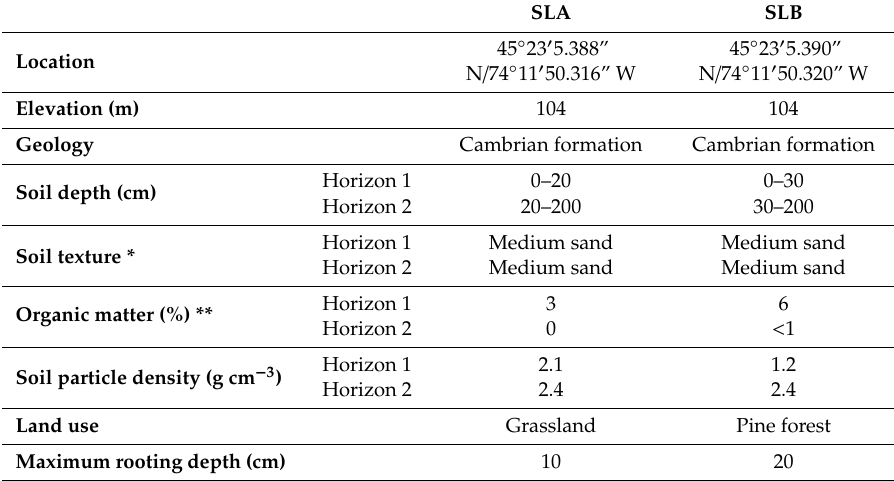
Table 1. Characteristics of the two study